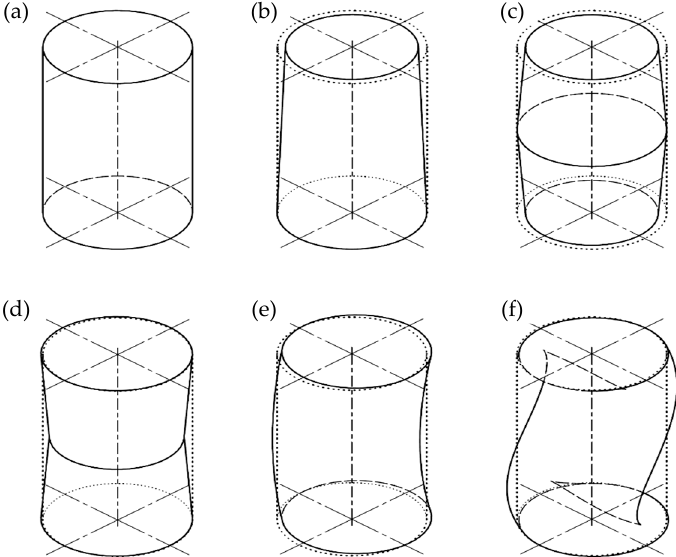
Figure 1. Examples of cylindricity deformations: ( a )—ideal cylinder, ( b )—conicity deviation, ( c )— barrel-like deviation, ( d )—saddle-like deviation, ( e )—median line deviation, ( f )—complex shape deviation (source [13]).